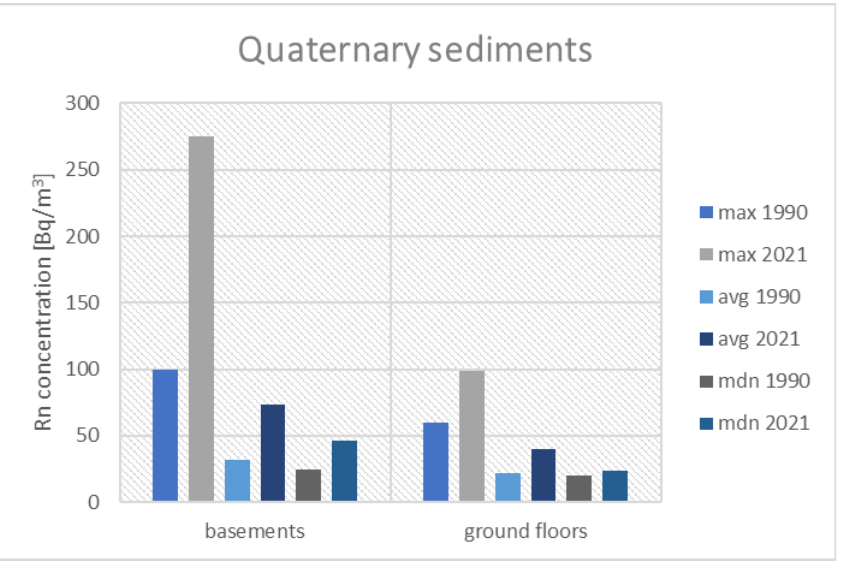
Figure 8. Comparison of radon concentrations in buildings located on Quaternary sediments. In basements in buildings, built on Quaternary sediments, the maximum concen- trations of radon, measured during the measurement campaign of 2021 (275 Bq/m 3 ), the average value (73 Bq/m 3 ) and the median (46 Bq/m 3 ) are higher than in the past (100 Bq/m 3 , 32 Bq/m 3 , and 25 Bq/m 3 ). The situation is similar in the case of rooms on the ground floor; max 99 Bq/m 3 vs. 60 Bq/m 3 , avg. 40 Bq/m 3 vs. 22 Bq/m 3 , and median 24 Bq/m 3 vs. 20 Bq/m 3 . Despite the observed increase in radon concentrations in